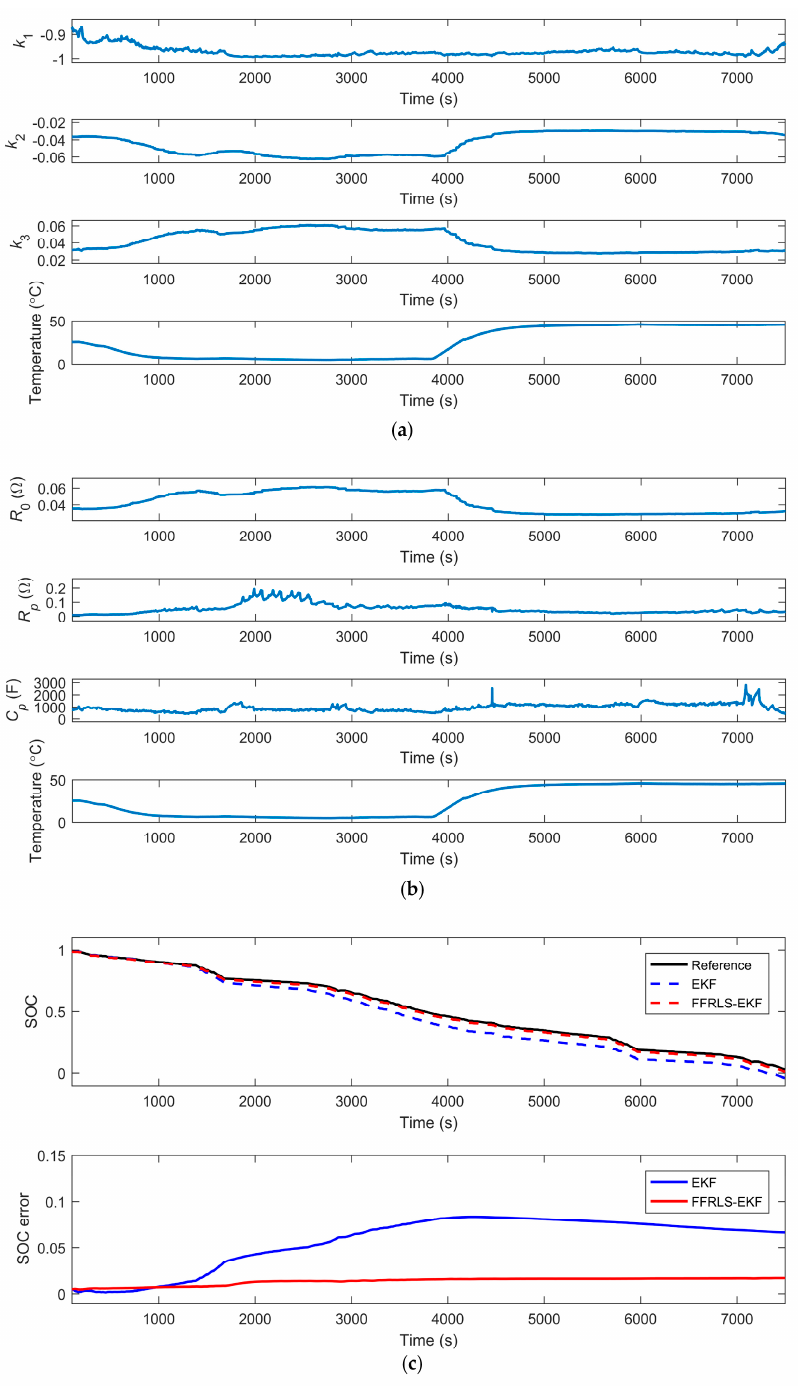
Figure 8. Calculation results of EKF and FFRLS-EKF without measurement noise: ( a ) Identification of k 1 , k 2 and k 3 ; ( b ) Identification of R 0 , R p and C p ; ( c ) SOC estimation results of EKF and FFRLS-EKF.